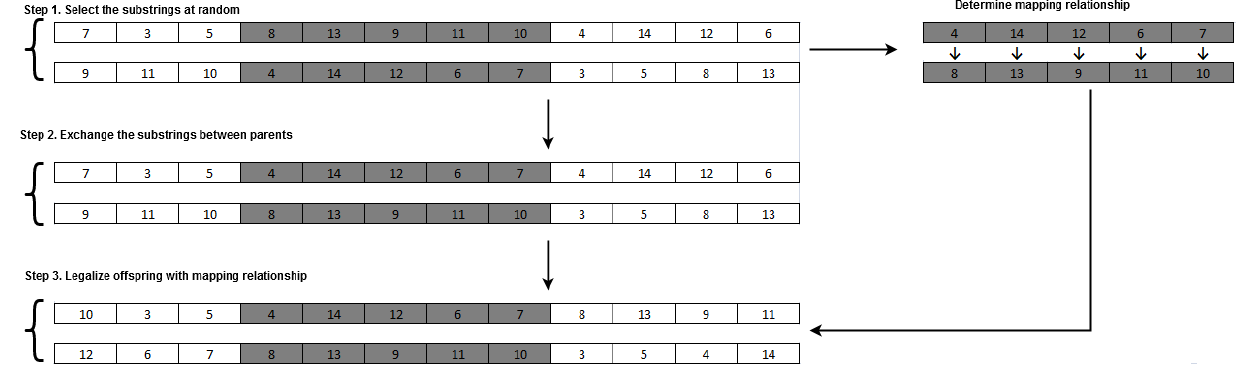
Figure 7. An illustration of the partially mapped crossover (PMX). Table 5. An example of depot and zone attributes .